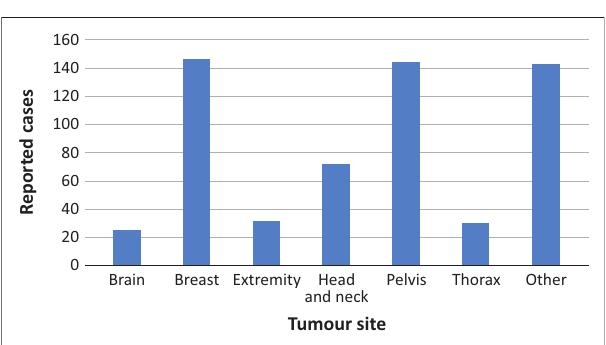
FIGURE 8: Incidence reports received per professional group.